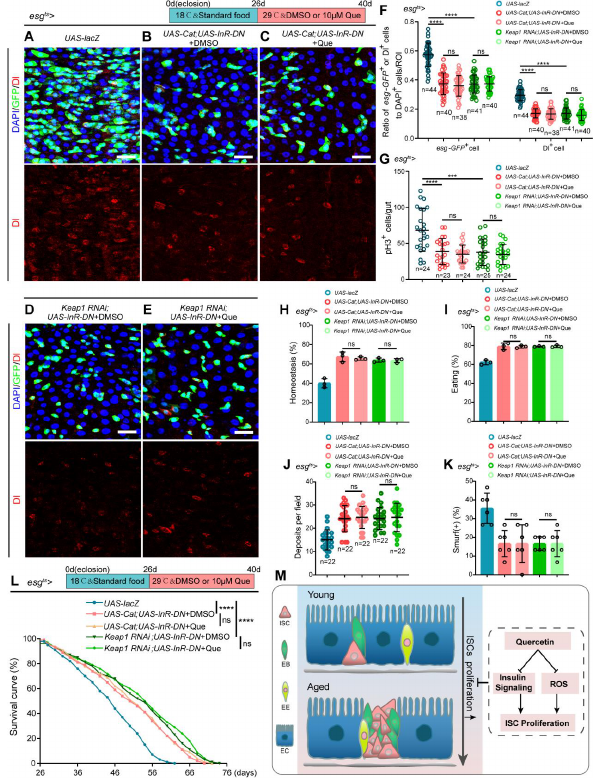
Figure 6. Que prevents age-related hyperproliferation of ISC through scavenging ROS and inhibiting insulin signaling pathway. ( A – E ) Representative immunofluorescence images of posterior midguts of flies carrying esg ts -Gal4 -driven UAS-lacZ ( A ), UAS-Cat; UAS-InR-DN + DMSO ( B ), UAS-Cat; UAS- InR-DN + Que ( C ), Keap1 RNAi; UAS-InR-DN + DMSO ( D ), and Keap1 RNAi; UAS-InR-DN + Que ( E ) stained with DAPI, GFP, and Dl. The top panels represent the merged images, whereas the bottom panels represent Dl. Scale bars represent 25 µ m. ( F ) The ratio of esg-GFP + cells and Dl + cells to DAPI + cells per ROI in the posterior midguts of flies in experiments ( A – E ). n: number of ROI counted. ( G ) The number of pH3 + cells in the whole gut of flies in experiments ( A – E ). n: number of gut counted. ( H , I ) The percentage of acid-base balanced intestines ( H ) and eating intestines ( I ) of flies in experiments ( A – E ). N ≥ 50 flies per group. Three independent experiments were conducted. ( J ) Quantifying the excretion deposits of flies in experiments ( A – E ). Each group included 30 flies and three independent experiments were conducted. n: number of field counted. ( K ) The percentage of the smurf (+) flies in experiments ( A – E ). Each group included 15 flies and three independent experiments were conducted. ( L ) Survival percentage of indicated genotypes of female flies. Each group included 100 flies. Three independent experiments were conducted. ( M ) Schematic model of the mechanism of quercetin action. Que prevents the hyperproliferation of ISCs via attenuating oxidative stress and inhibiting the insulin signaling pathway. Error bars represent SDs. Log-rank test was used for lifespan analysis. Student’s t -tests, *** p < 0.001, **** p < 0.0001, and non-significance (ns) represents p >